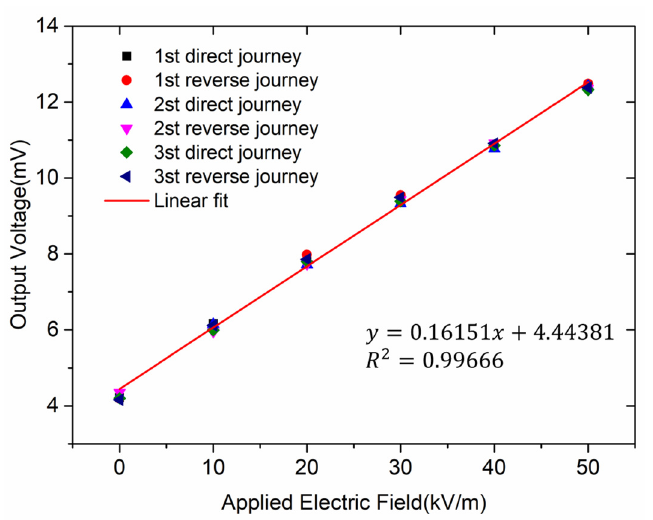
Figure 13. Response of the microsensor versus the applied electric field in three roundtrip measurements.